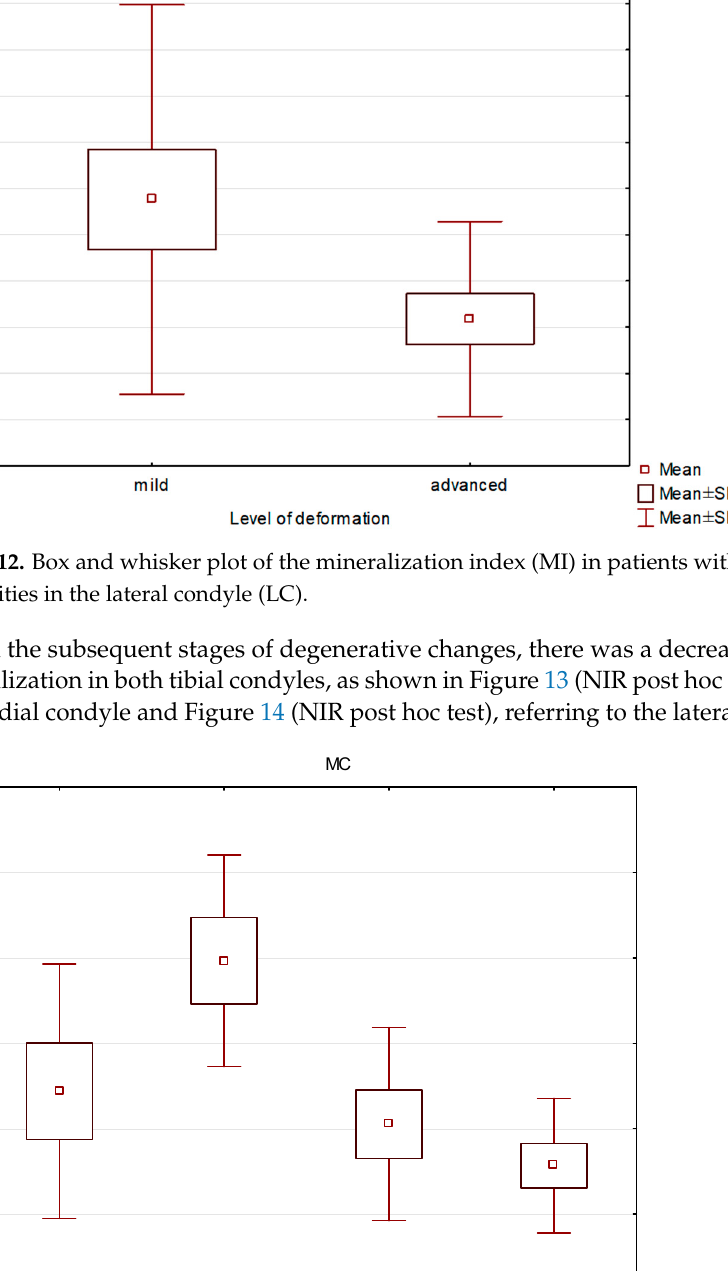
Figure 11. Box and whisker plot of the mineralization index (MI) in patients with mild and severe deformities in the medial condyle (MC).